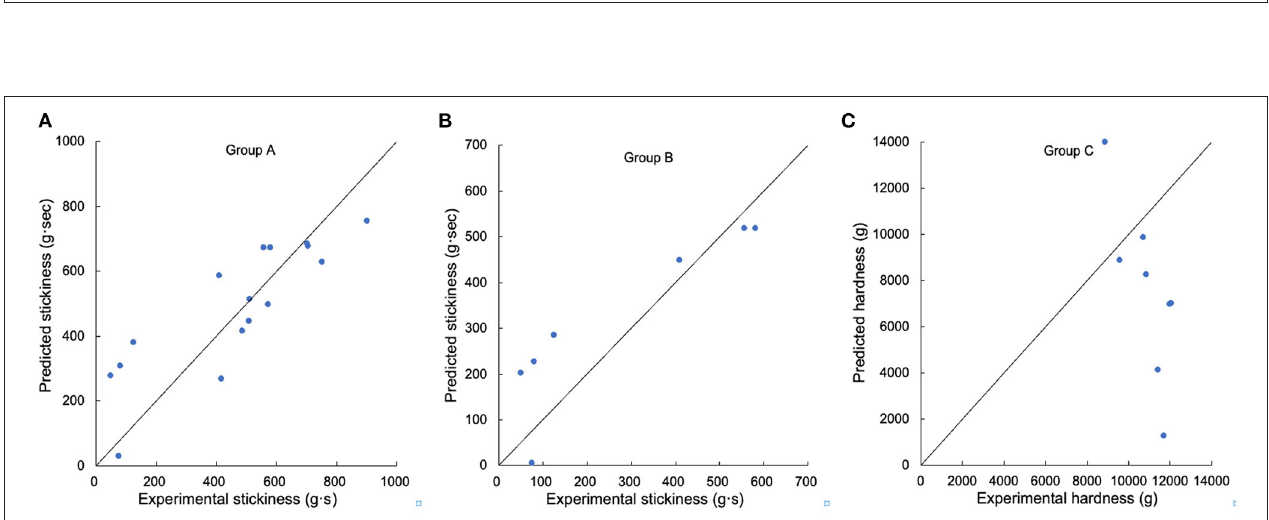
FIGURE 7 | Testing the suitability of linear regression models for textural properties. (A) Comparison of experimental and predicted stickiness from Group A, (B) comparison of experimental and predicted stickiness from Group B, (C) comparison of experimental and predicted hardness from Group C. Samples DR S10, S61–S67, and S39, S45, S68–S73 were used in Group A, samples DR S10, S61–S67 were used in Group B, and samples DR S39, S45, S68–S73 were used in Group C.